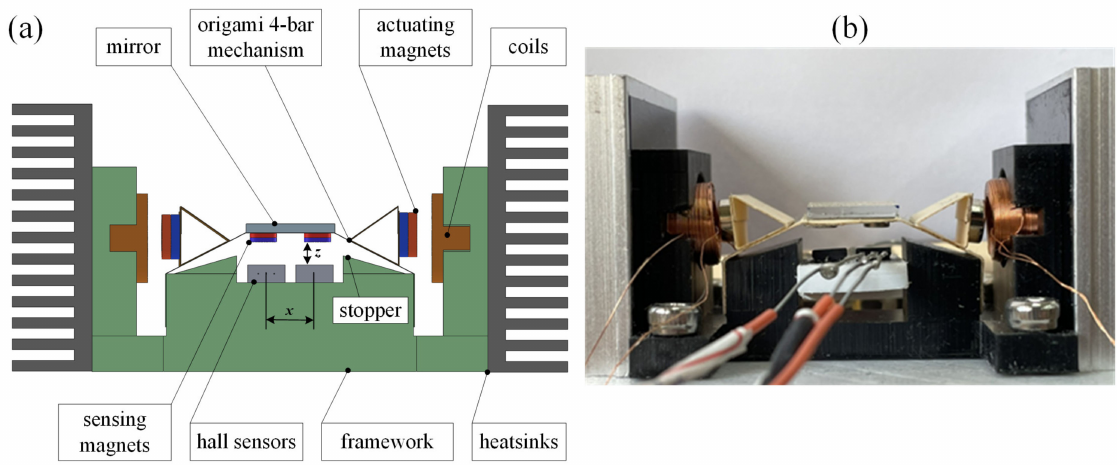
Figure 2. ( a ) Schematic diagram and ( b ) photograph of the proposed origami laser galvanometers.